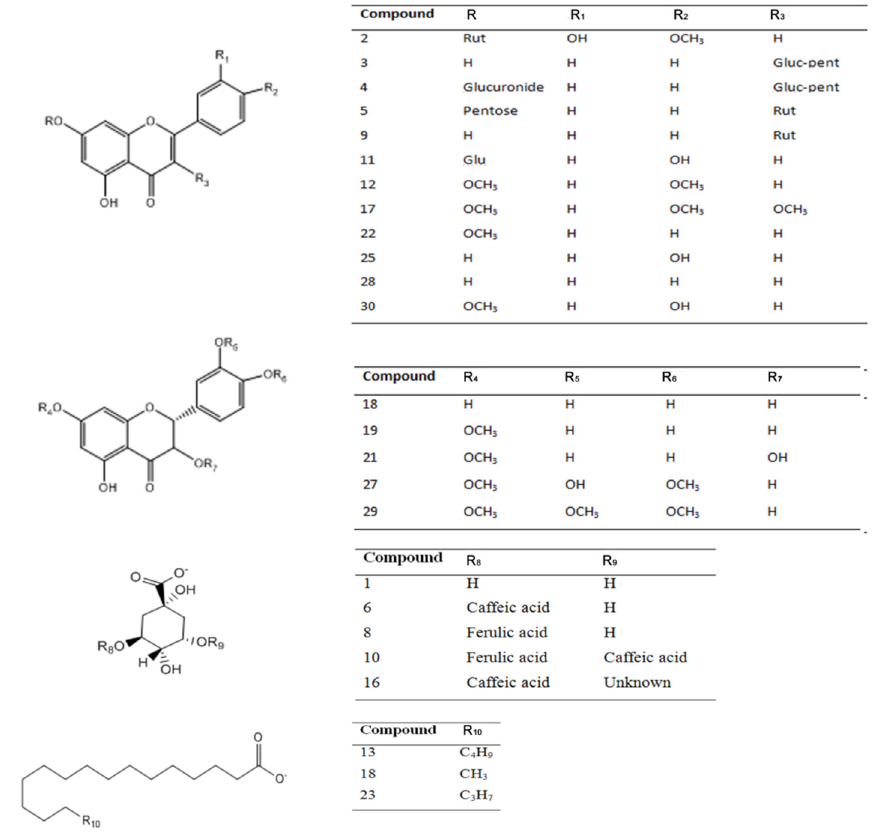
Figure 3. Structures of the main compounds detected in Nolana leptophylla , N. aplocaryoides and N. ramosissima collected in Paposo Valley, II region of